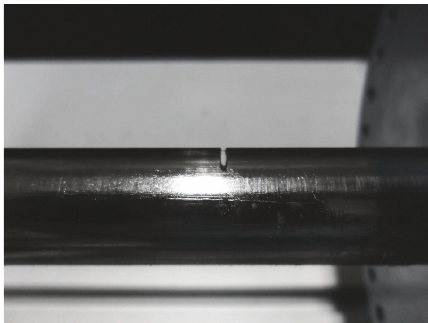
Figure 14: Small notch representing an open crack in the shaft of the test